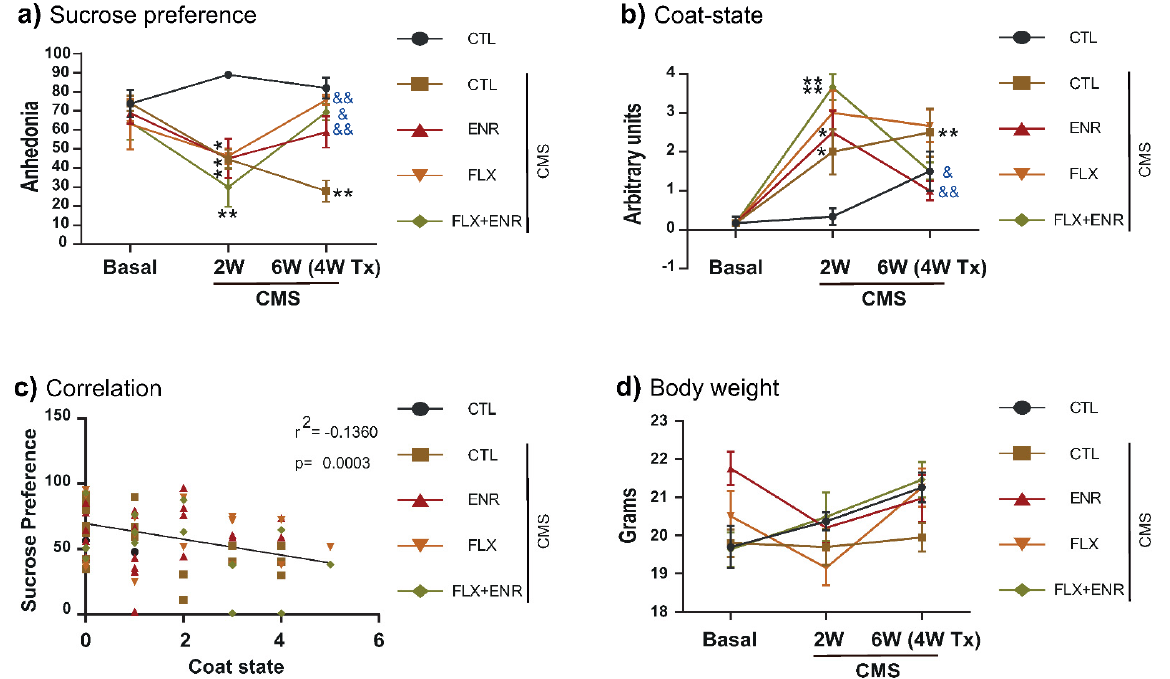
Figure 2. Environmental enrichment and fluoxetine reverse depressive-like behavior. Female BALB/c mice exposed to chronic mild stress (CMS) and treated with fluoxetine (FLX), environmental enrichment (ENR), or the combination (FLX + ENR) were analyzed to determine ( a ) anhedonia and ( b ) the coat state in the second and sixth week of CMS. Data represent the mean ± standard error of the mean (SEM). Two-way ANOVA was followed by the Holm–Sidak test. Symbols “asterisks” in ( a , b ) indicate a p < 0.001 versus the control un-stressed group. Symbols “&” indicate p < 0.033 versus CMS group. ( c ) A significant negative correlation was found between SP and the coat state without significant differences in body weight ( d ).